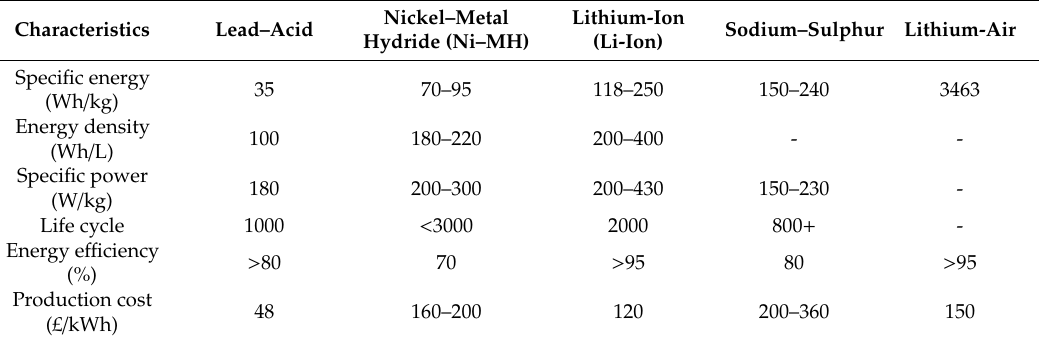
Table 3. The comparison of energy storage specifications for electric vehicles (EVs) [20–25].